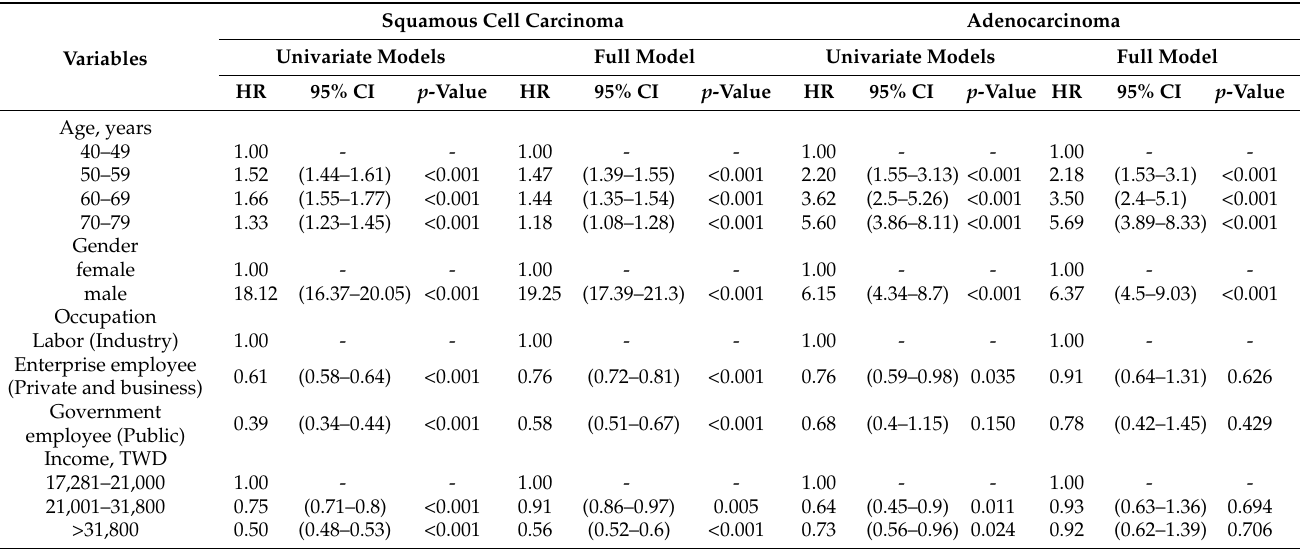
Table 4. Univariate and multivariable Cox proportional hazard models of esophagus cancer